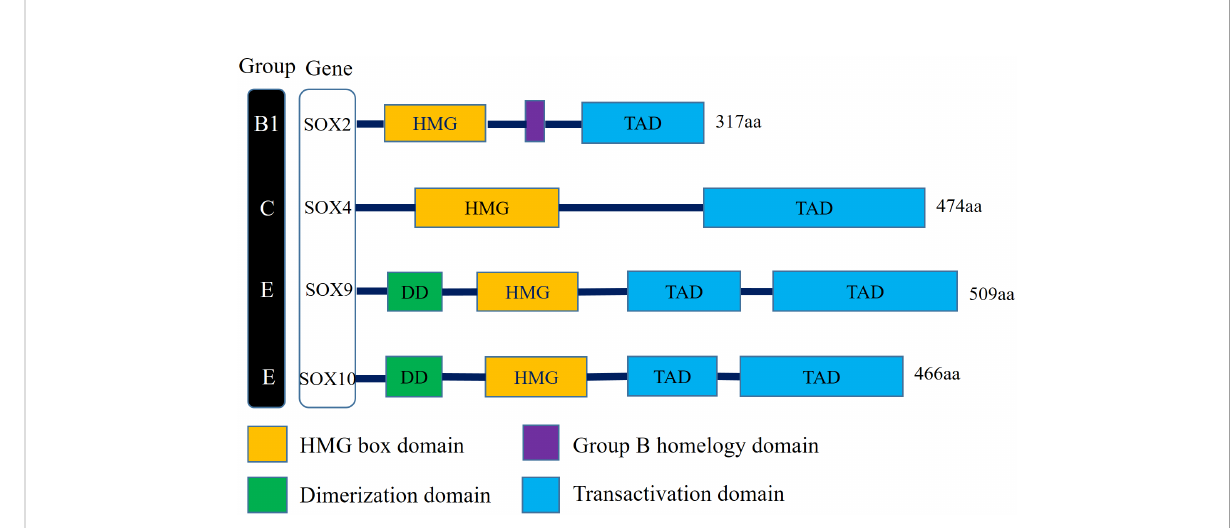
FIGURE 1 Schematic illustration of structures of the Sox gene family involved in human bladder cancer. SOX2 belongs to SOX family group B1, SOX4 belongs to SOX family group C, SOX9 and SOX10 belong to SOX family group E. All family members have the DNA-binding HMG domain in common. (HMG, High-mobility group box domain; TAD, Transactivation domain; DD, Dimerization